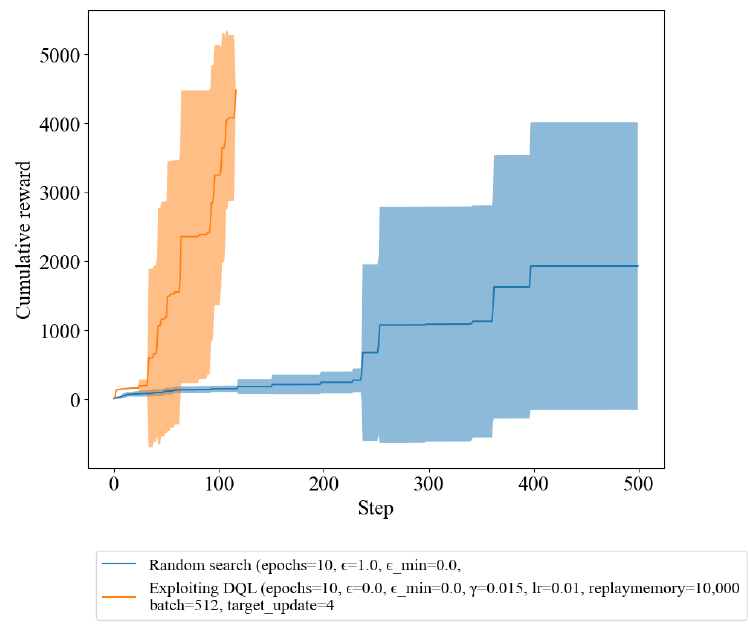
Figure 2. Reward of random search and exploiting DQL.